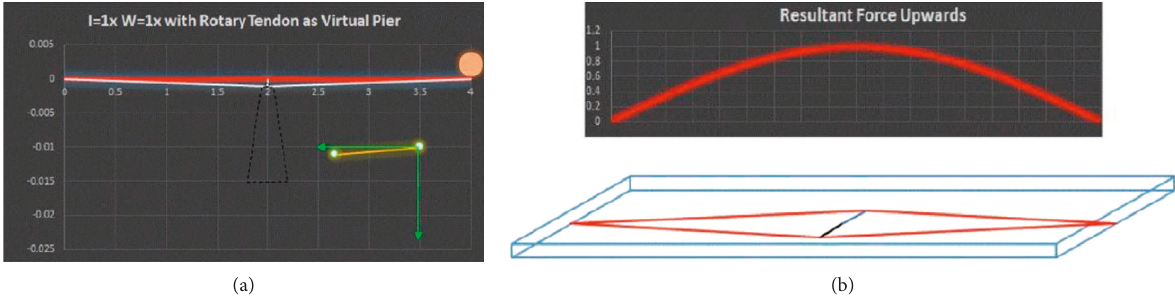
Figure 6: Rotation angle and upwards resultant force for the fifth stage of a bridge with the